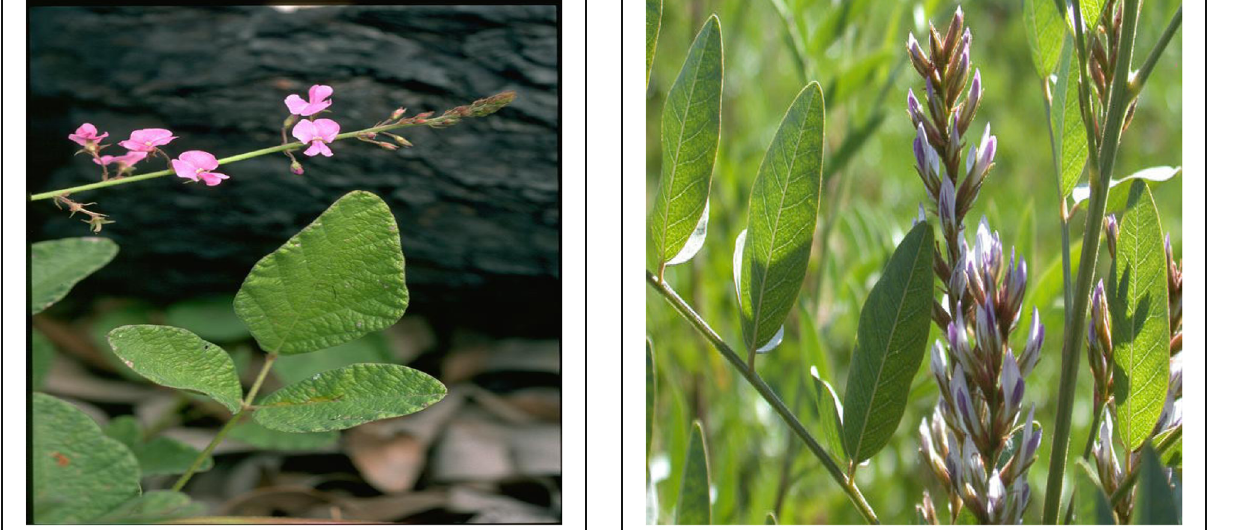
Fig. 7 Desmodium gangeticum . This extinct non-endemic species belongs to the plant family Leguminosae (Fabaceae or Papilionaceae) (Copy source Jacob Thomas Pandalayil)